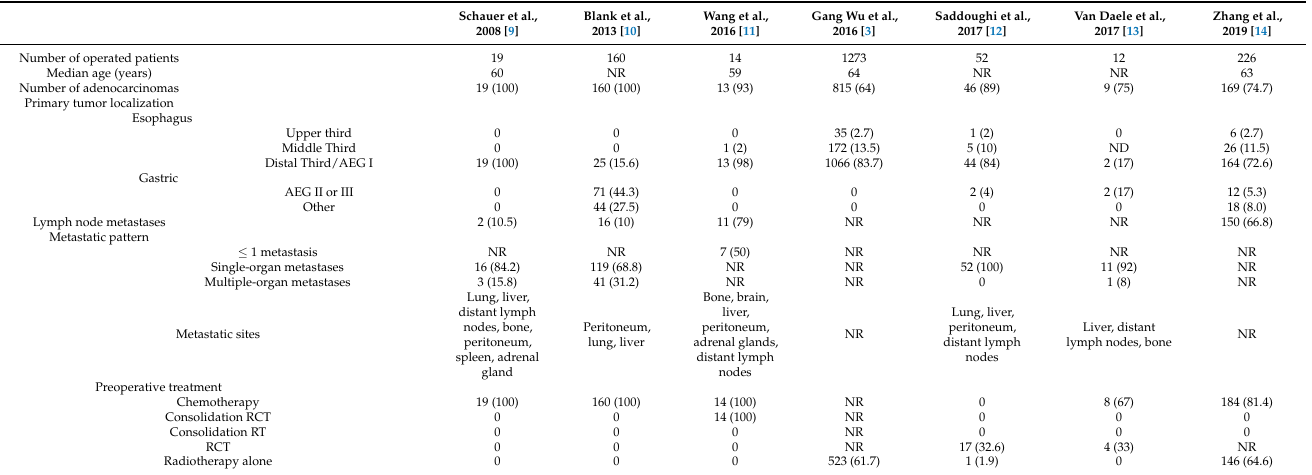
Table 3. Patients’ cancer characteristics: tumor type, primary and secondary tumor localizations, and preoperative